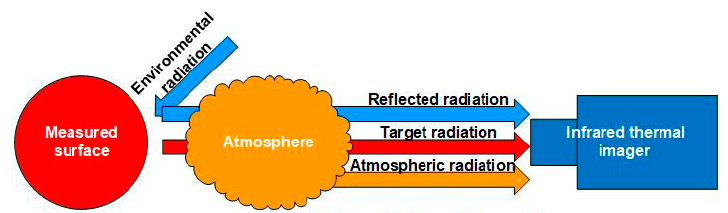
Figure 3. Measurement principle of thermal infrared imagers.